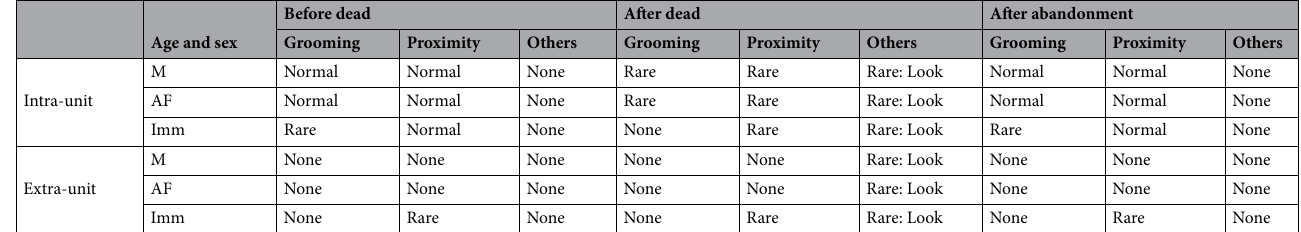
Table 3. Response to mother by group members. AM: Adult-male, AF: Adult-female, Imm: Immature (infant or juvenile); 2, Inv: Investigate, includes looking closely, sniffing, briefly touching; Look: visual orientation toward target individual but with no close approach; Aff: affiliative behavior including grooming, embracing, or gentle